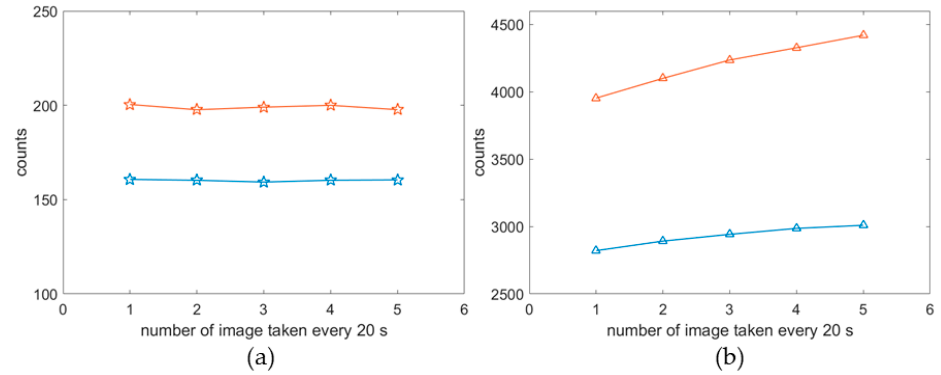
Figure 5. Measured intensities averaged over a centrally selected ROI of the images taken consecutively every 20 s ( a ) with 125 mm lead filter and ( b ) without additional lead filters. Red and blue curves correspond to the Cu- and Ag-activated 1.5 mm-thick scintillators, respectively.